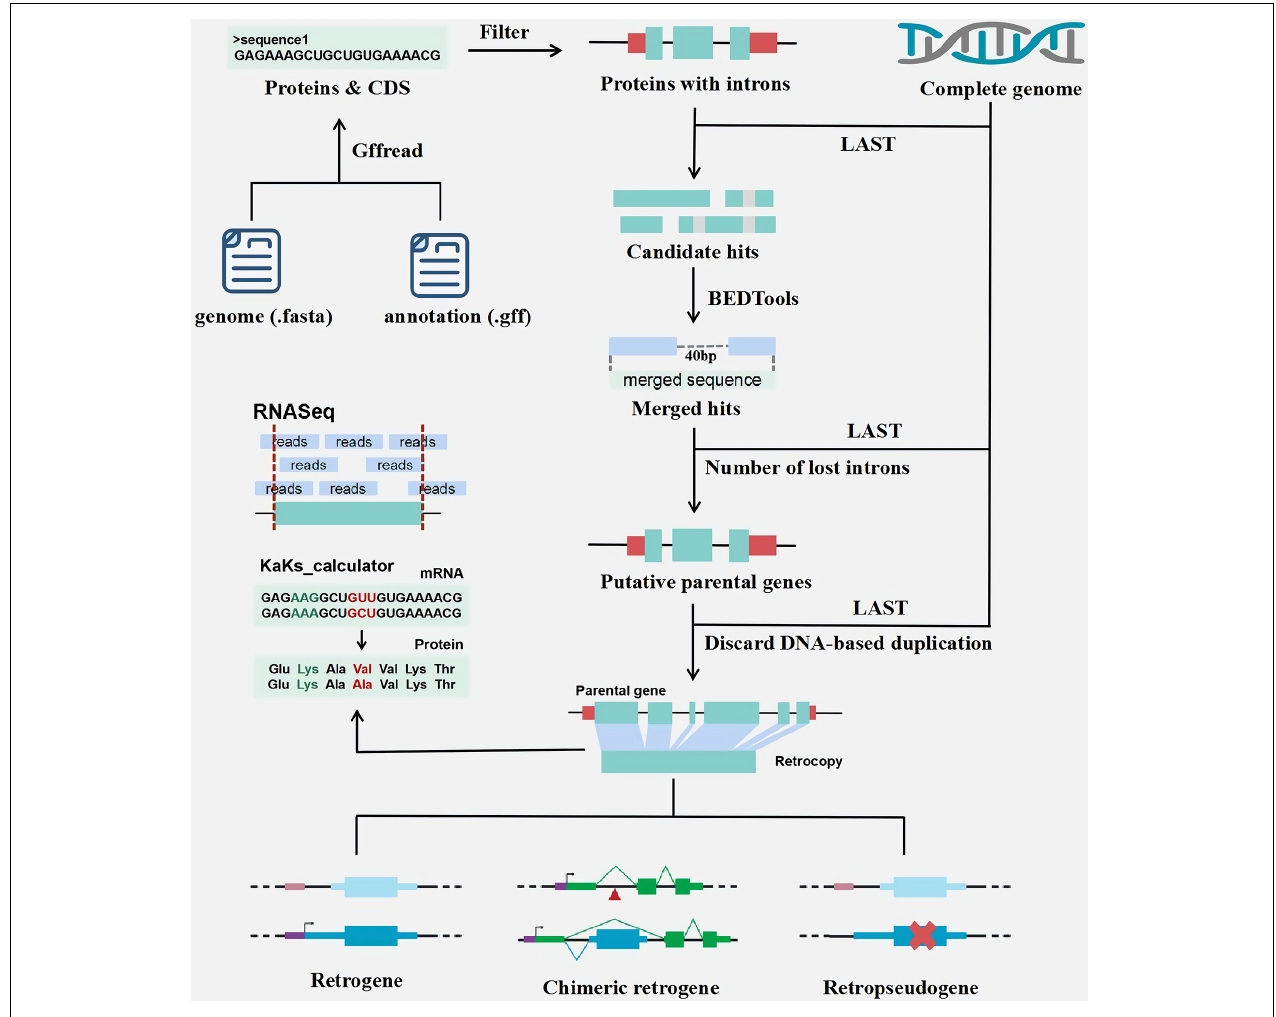
FIGURE 1 | The pipeline of retrocopy